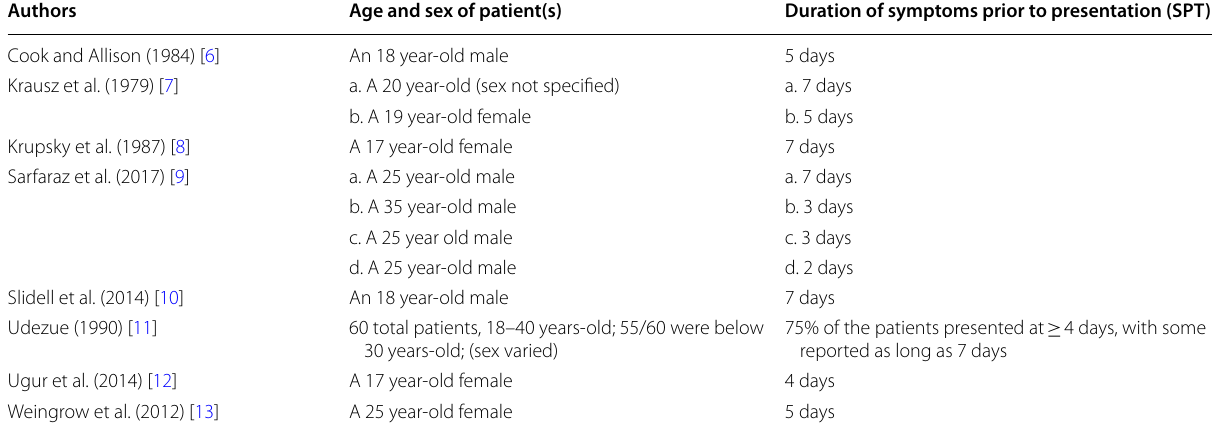
Table 1 Duration of symptoms to presentation in rare cases of young sigmoid volvulus cases